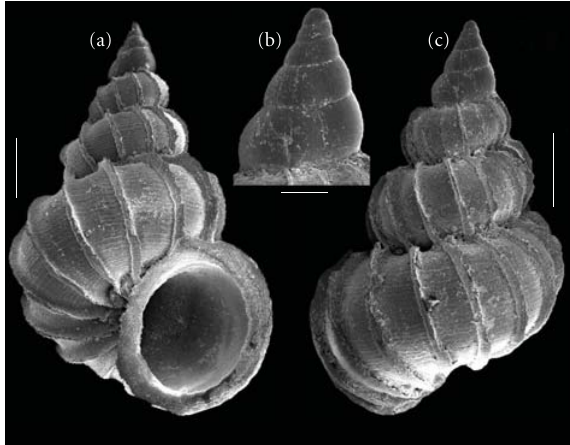
Figure 2: (a–c) Epitonium cf. celesti (LMUFRPE); (a) ventral view, (b) protoconch, and (c) dorsal view. Scale bars: (a) and (c) 500 μ m, (b) 200 μ